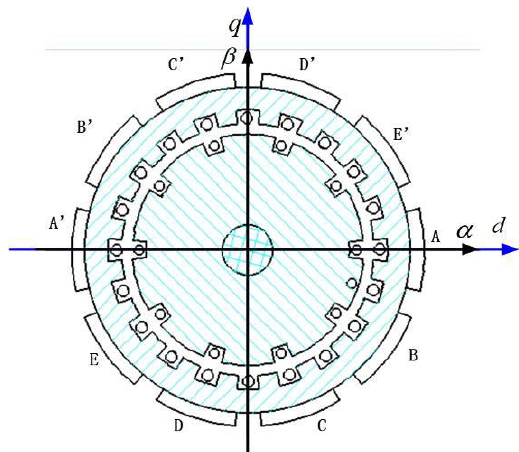
Figure 1. Five-phase induction motor structural topology.